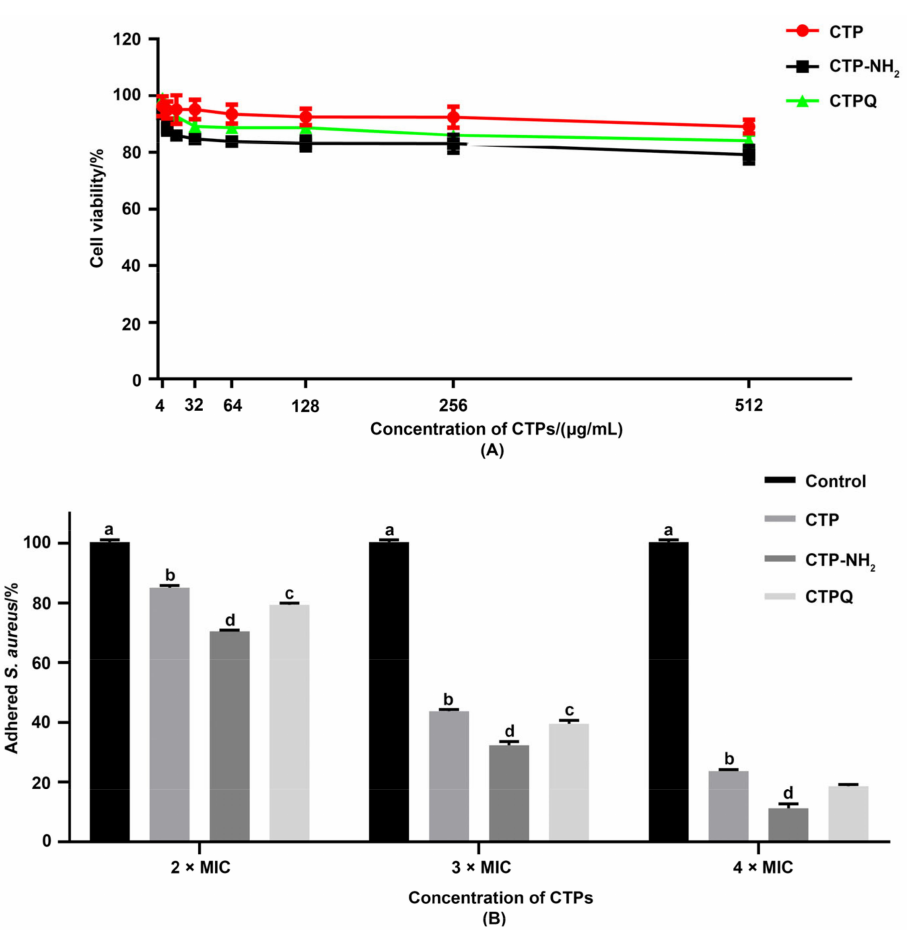
Figure 13. ( A ) Cell viability of intestinal porcine epithelial cell line (IPEC-J2) upon exposure to CTPs and ( B ) inhibitory effect of CTPs against the adherence of S. aureus ATCC 43300 to IPEC-J2 cells. a–d : Different lowercase letters mean significantly different ( p < 0.05) values were expressed as mean ± SEM ( n =